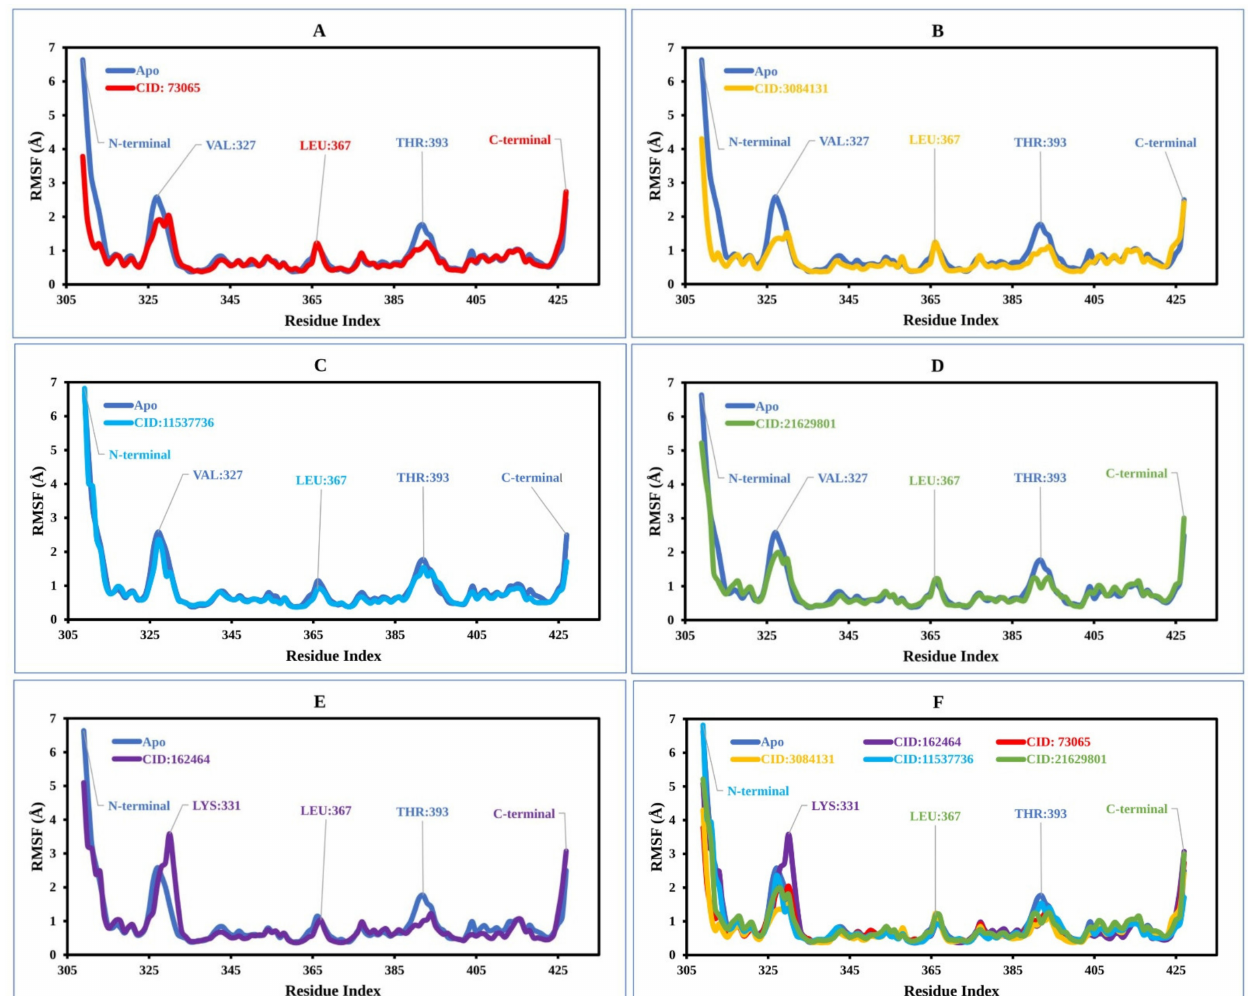
Figure 5. The RMSF values extracted for the C α atoms of the five selected compounds in complex with the MCPyV LT protein (blue) in complex with the compounds ( A ) CID: 73065 (red), ( B ) CID: 3084131 (yellow), ( C ) CID: 11537736 (light blue), ( D ) CID: 21629801 (green), and ( E ) CID: 162464 (purple), and ( F ) shows the RMSF for all compounds and the protein